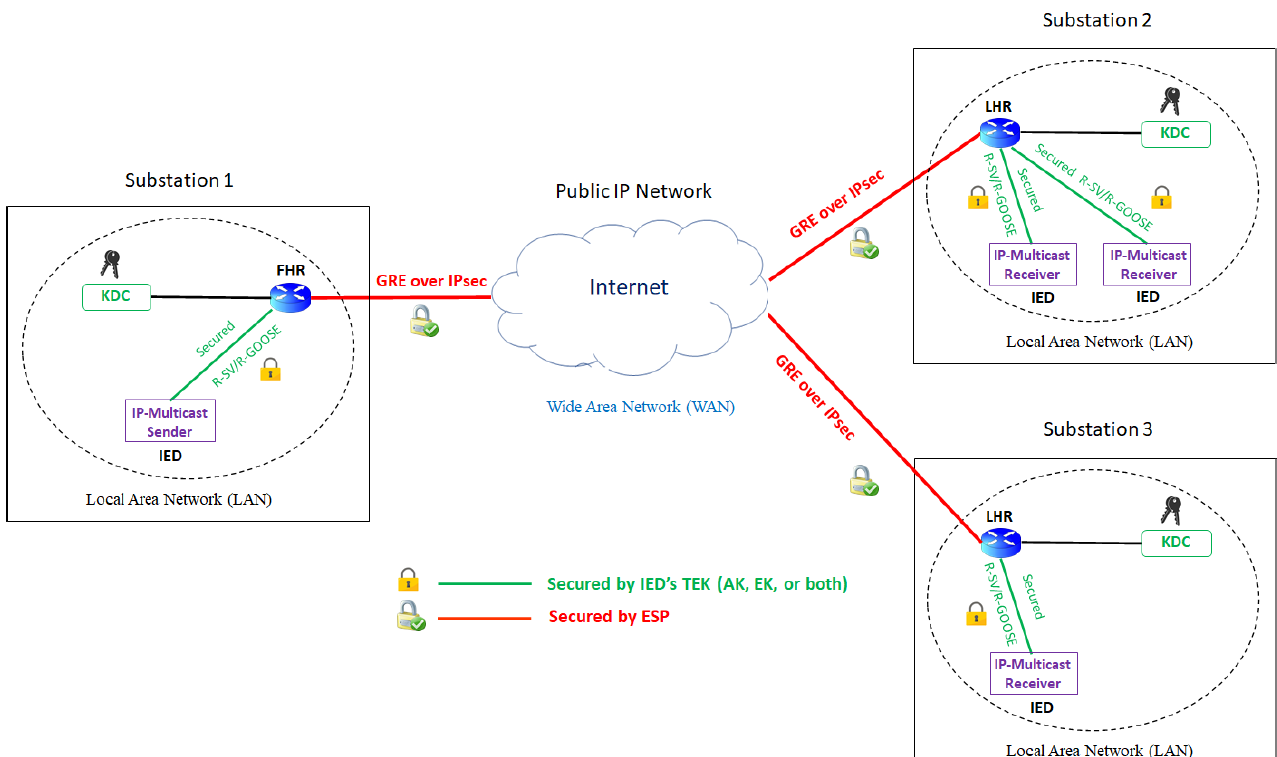
Figure 15. Secured messages in the secured communication path (Defense-in-Depth Security for multicast communication via public WAN).